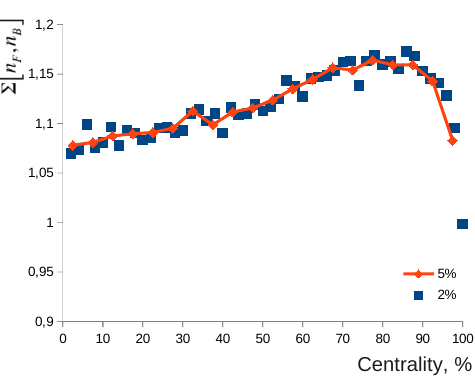
Figure 2. Strongly intensive quantity Σ NN as a function of centrality, calculated in the Monte Carlo model with string fusion for Pb-Pb collisions at 2.76 TeV. Two centrality class binning (2% and 5%) are shown by di ff erent markers